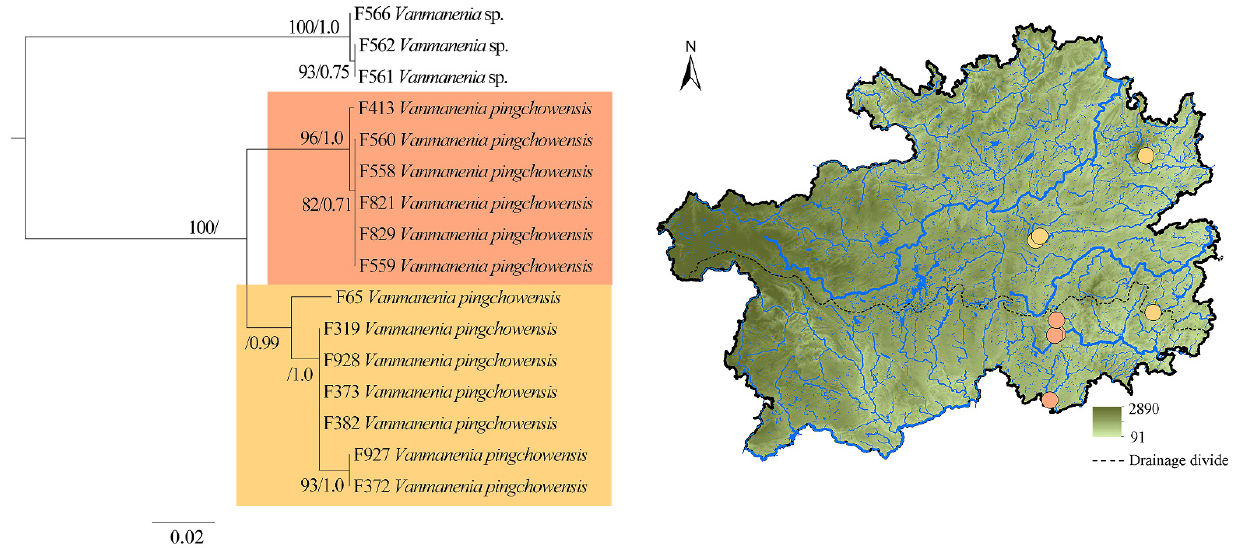
Figure 5. Phylogenetic tree showed cryptic diversity of Vanmanenia pingchowensis and collection locations. Results for BI analysis were mapped onto the ML tree. Numbers on the branches are bootstrap percentages (%) from ML and posterior probability from BI. ML with bootstrap >50% and BI with PP >0.5 were shown. The scale bar indicates the number of substitutions per site.